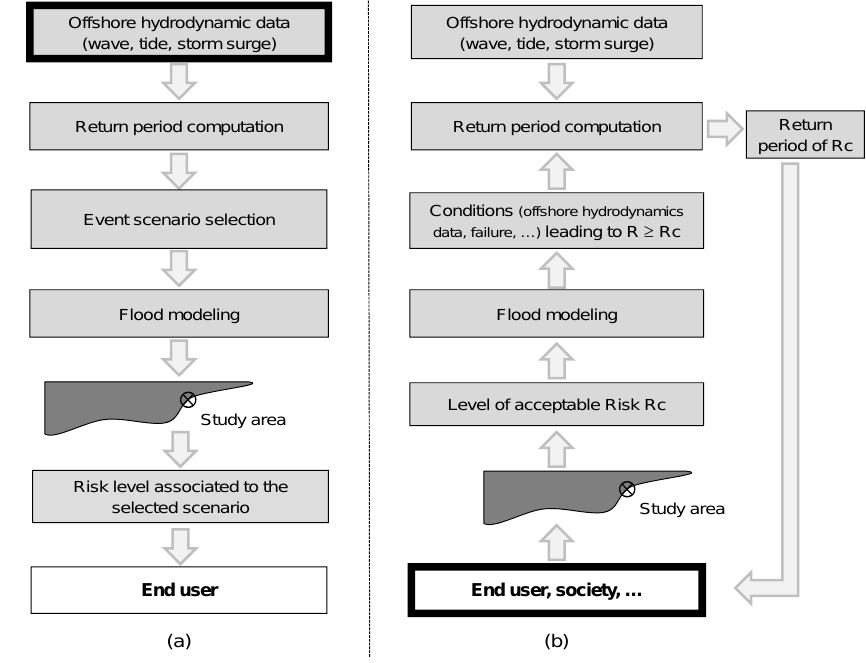
Fig. 1. Principle of direct (a) and inverse (b) approaches. The thick boxes indicate the main input of the approach.